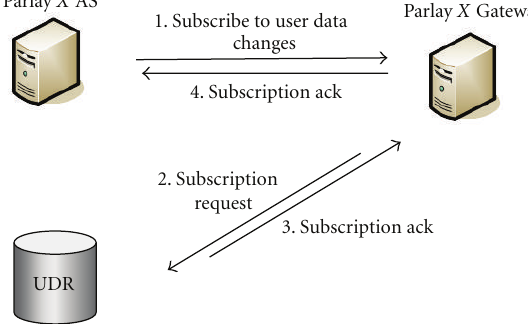
Figure 5: Subscription to QoS-related user data change.